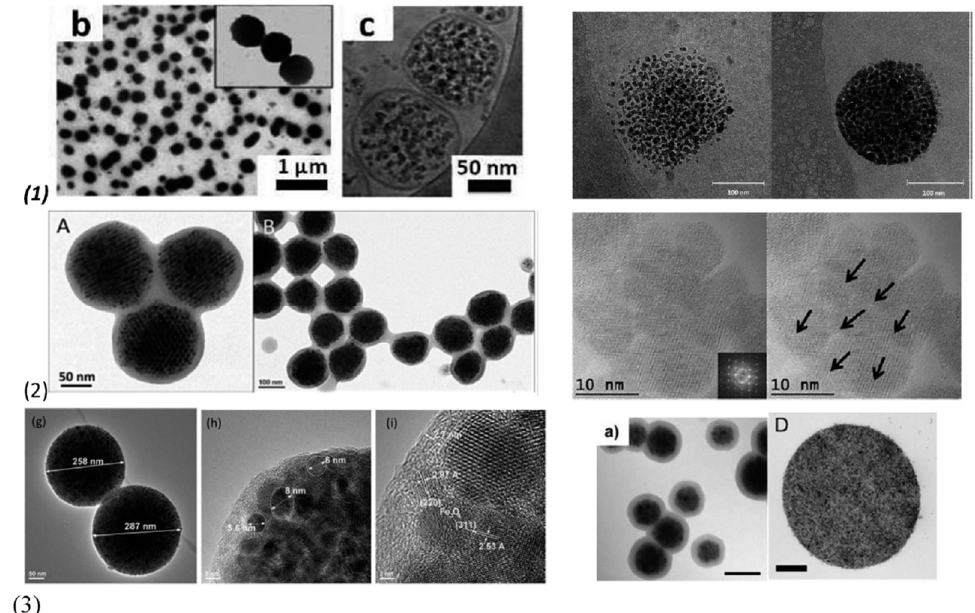
Figure 1. Magnetic multi-core particles obtained by di ff erent synthesis procedures: ( 1 ) encapsulation of magnetic nanoparticles (MNPs) into liposomes, polymersome : left —TEM ( b ) and cryo-TEM ( c ) micrographs of Ultra Magnetic Liposomes (UMLs) prepared by reverse phase evaporation process (REV) process. MNPs are trapped inside unilamellar vesicles ( c ) and dipole − dipole interaction can occur as exemplified by magnification ( b ) ([73]); right —Cryo-TEM image showing iron oxide nanoparticles incorporated in the polymersome membrane with 4.1% iron oxide (left), and 17.4% iron oxide (right) ([77]). ( 2 ) thermal decomposition : left —TEM images of polymer encapsulated colloidal ordered assemblies (polymer-COA) at higher ( A ) and lower ( B ) resolution. The dark pattern ( A ) results from the ordering of the closed packed assemblies within the nanobeads, while the brighter gray ring is caused by the polymer shell (lower electron density) of around 20 nm thickness ([59]); right —High Resolution TEM of multi-core MNP showing the continuity of the crystal lattice at the grain interfaces. The Fourier transform of